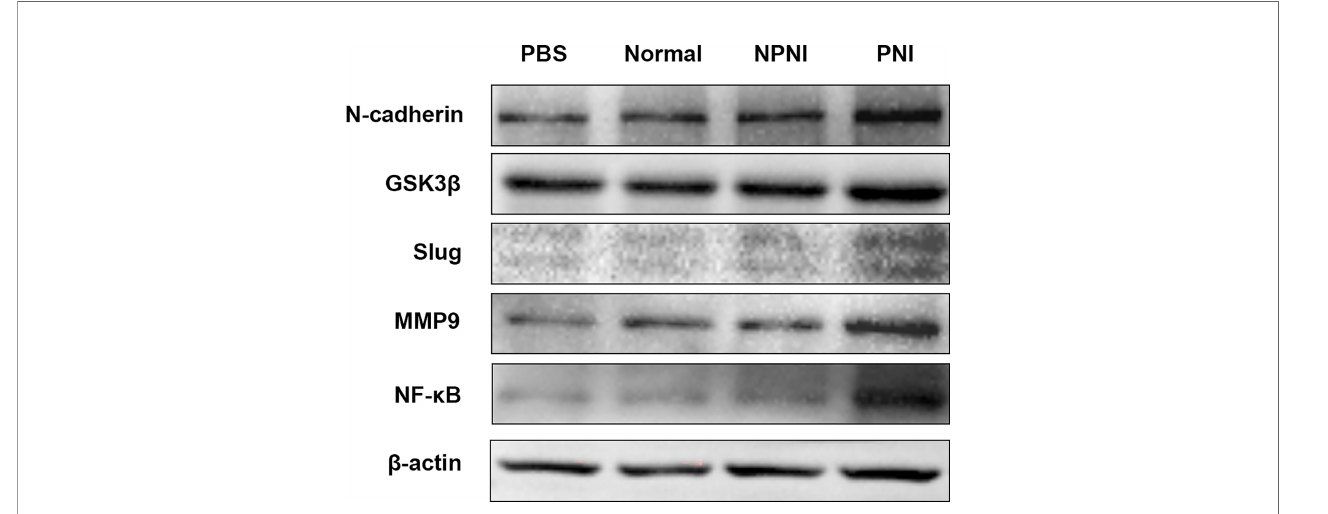
FIGURE 6 | EMT-related protein expression in SW480 cells stimulated with EVs. Western blot analysis of N-cadherin, GSK-3 b , Slug, MMP9, and NF-kB protein expression in SW480 cells stimulated with PBS and serum-derived EVs from the healthy volunteer, PNI and NPNI